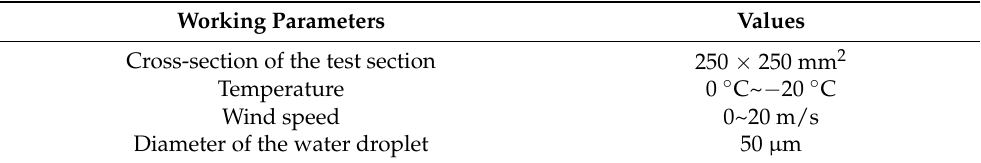
Table 1. Working parameters of the icing wind tunnel.